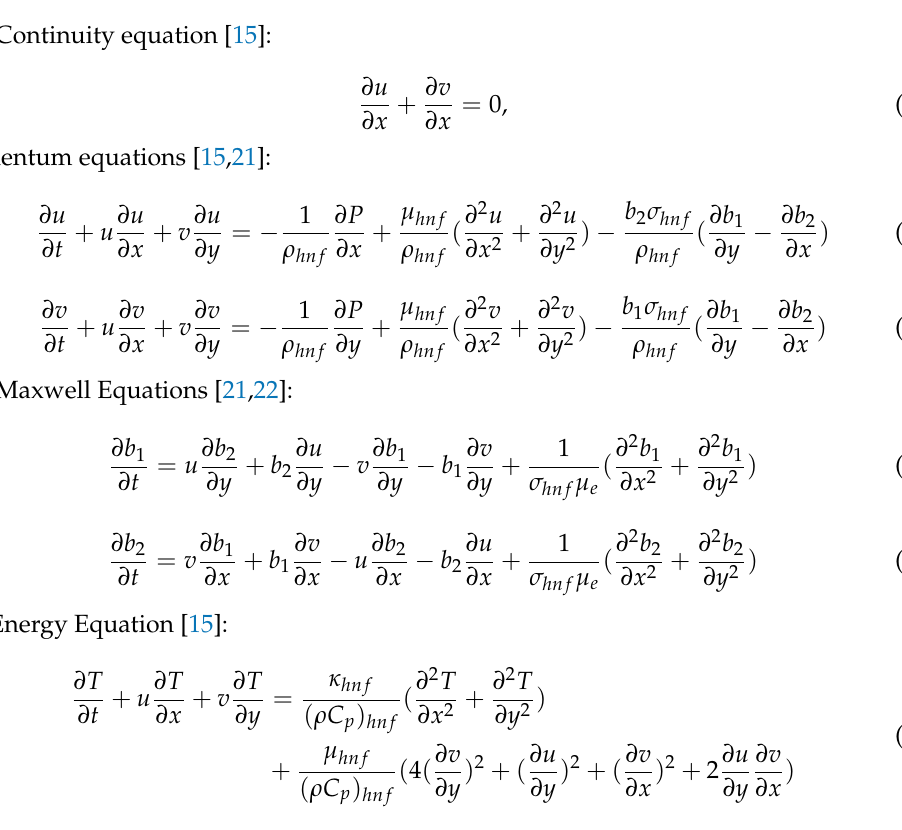
Figure 1. Geometry of the problem with coordinate